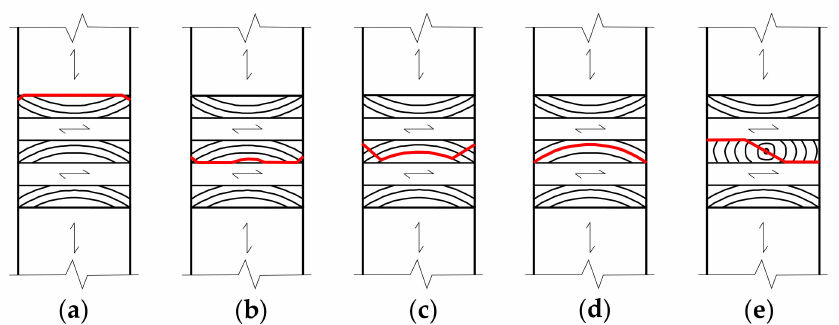
Figure 7. Classification of common fracture patterns (bold lines in red): ( a ) inter interface fracture pattern, partially radially at the edges; ( b ) intra interface fracture, partially radially at the edges and tangentially at the center; ( c ) intra W-fracture, partially radially and partially tangentially; ( d ) intra tangential fracture; ( e ) intra fracture through